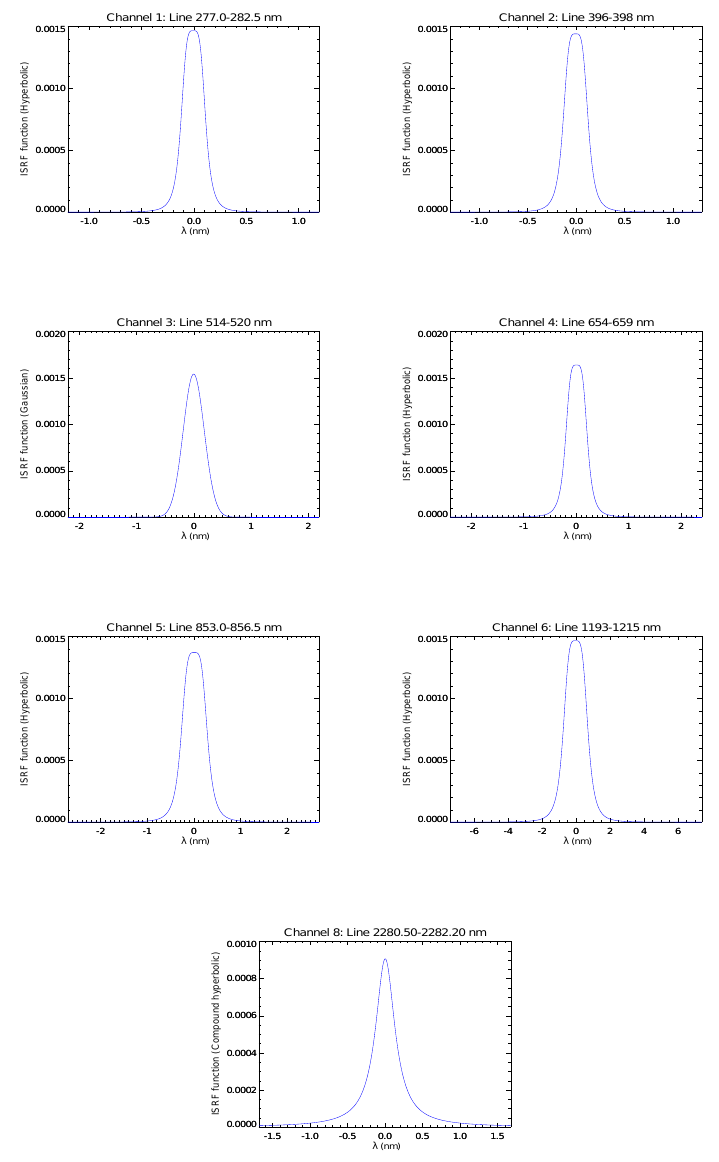
Figure 10. Examples of retrieved ISRF functions from our solar line fittings, in Figures 3–9, in SCIAMACHY channels. The corresponding function shape are shown in the y-axis label (see also Table 4).